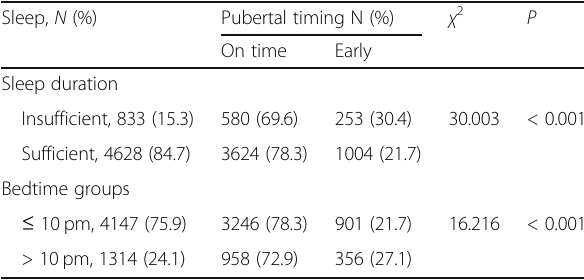
Table 3 Unadjusted analyses between sleep duration, bedtime, and pubertal timing